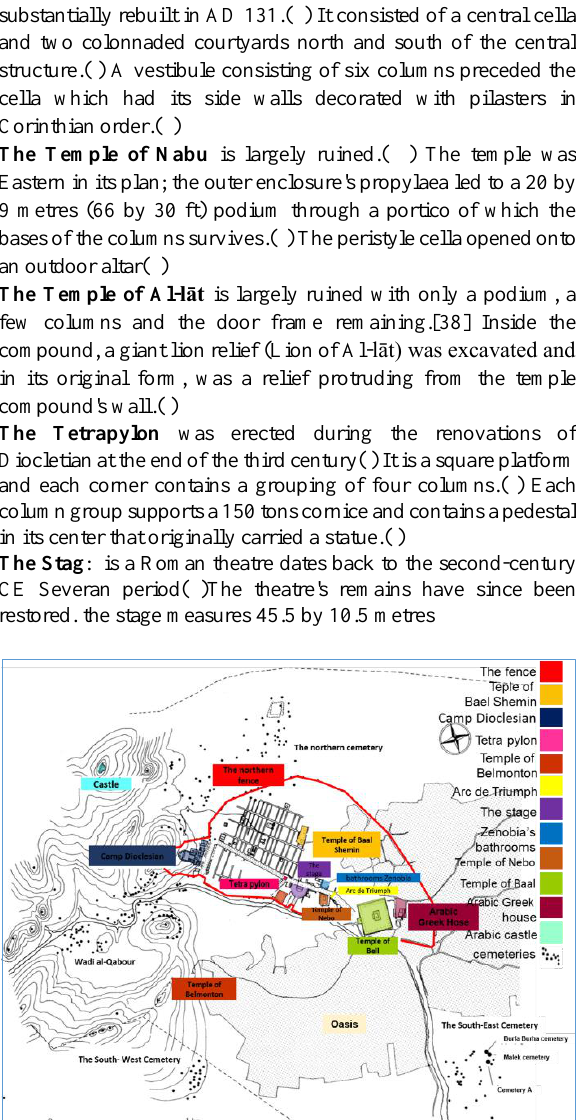
Figure (5) The cemeteries/wadi al-Qabour